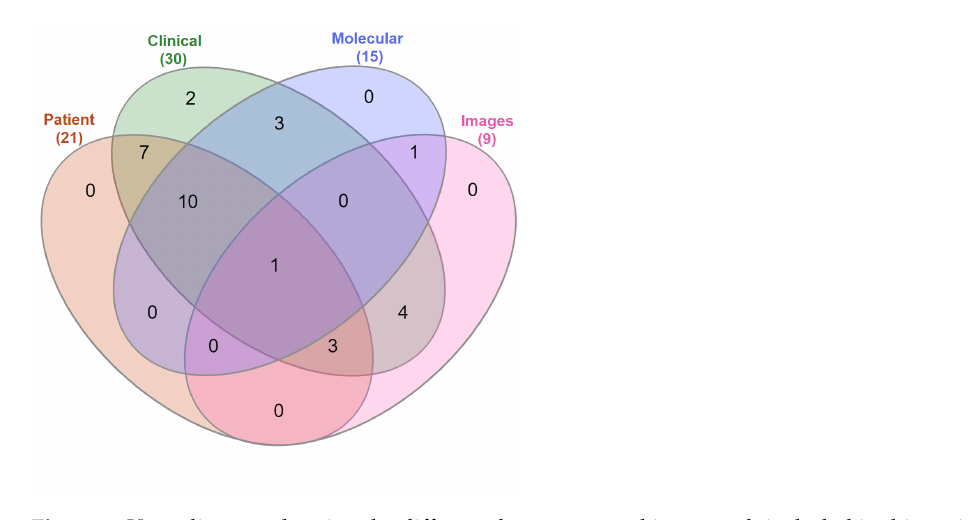
Figure 4. Venn diagram showing the different data types used in research included in this review.